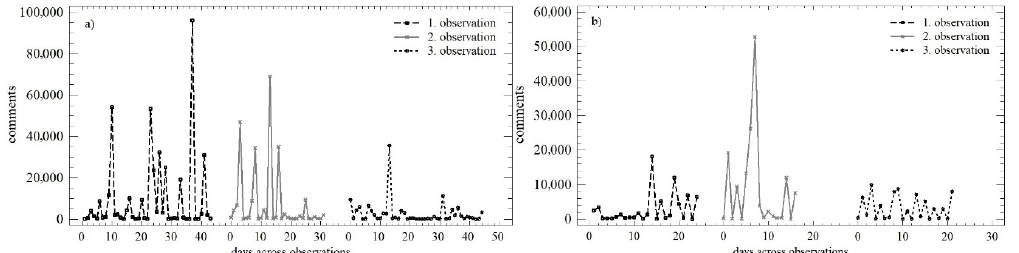
Figure 3. Density plot of the number of posts over the three monitored observation periods: ( a ) observation no. 1; ( b ) observation no. 2; ( c ) observation no. 3.